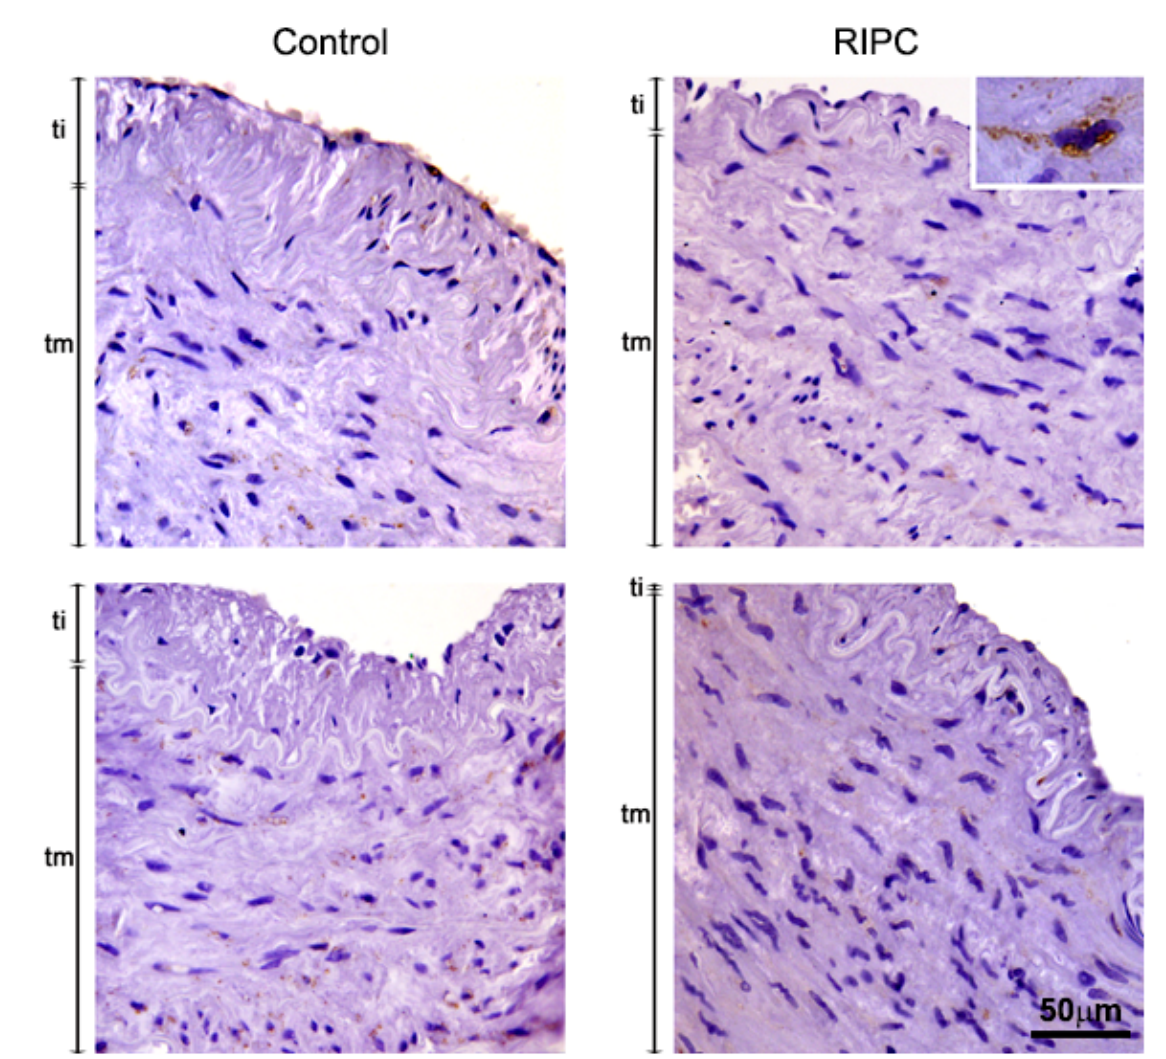
Figure 4. Immunohistochemical analysis of nNOS in tunica interna (ti) and tunica media (tm) of ITA from non-RIPC (control) patients ( left ) and patients with applied RIPC protocol ( right ) during urgent CABG. Immunopositivity for nNOS in both non-RIPC patients and RIPC patients was primarily detected in smooth muscle cells, while weak endothelial nNOS immunopositivity was observed in some cases. Insert: nNOS expressing cells. Scale bar: 50 µ m.